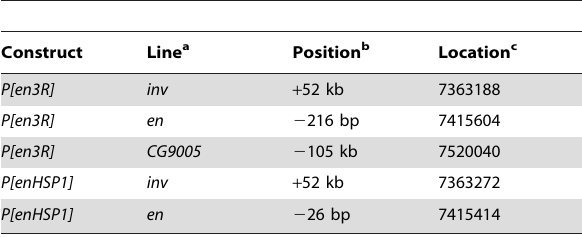
Table 3. P[enHSP1] insertions on chromosomes carrying en D 1.5